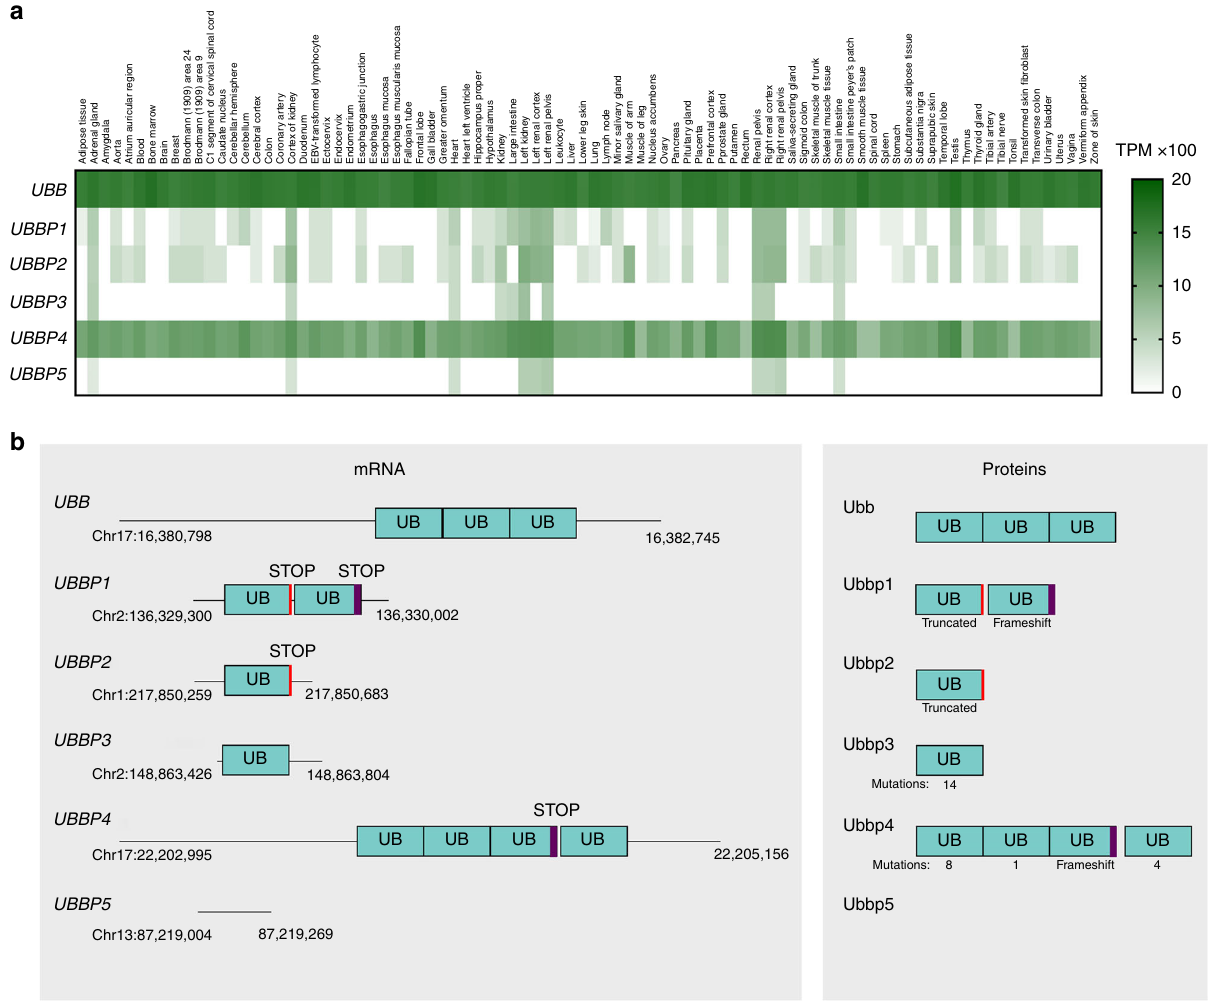
Fig. 1 UBB pseudogenes are expressed and encodes ubiquitin variants. a Expression levels analysis of UBB and UBB pseudogenes 1 – 5 through RNASeq data available through GTEx Portal from different tissues. b Schematic of UBB and UBB pseudogenes 1 – 5 mRNA and proteins potentially resulting from translation. Only UBBP3 and UBBP4 encode Ub variants with a diglycine at the C-terminal. The UBBP4 gene contains two ORFs. The fi rst one encodes three Ub repeats, with the third Ub containing a frameshift resulting in a premature stop codon. The second ORF encodes a Ub